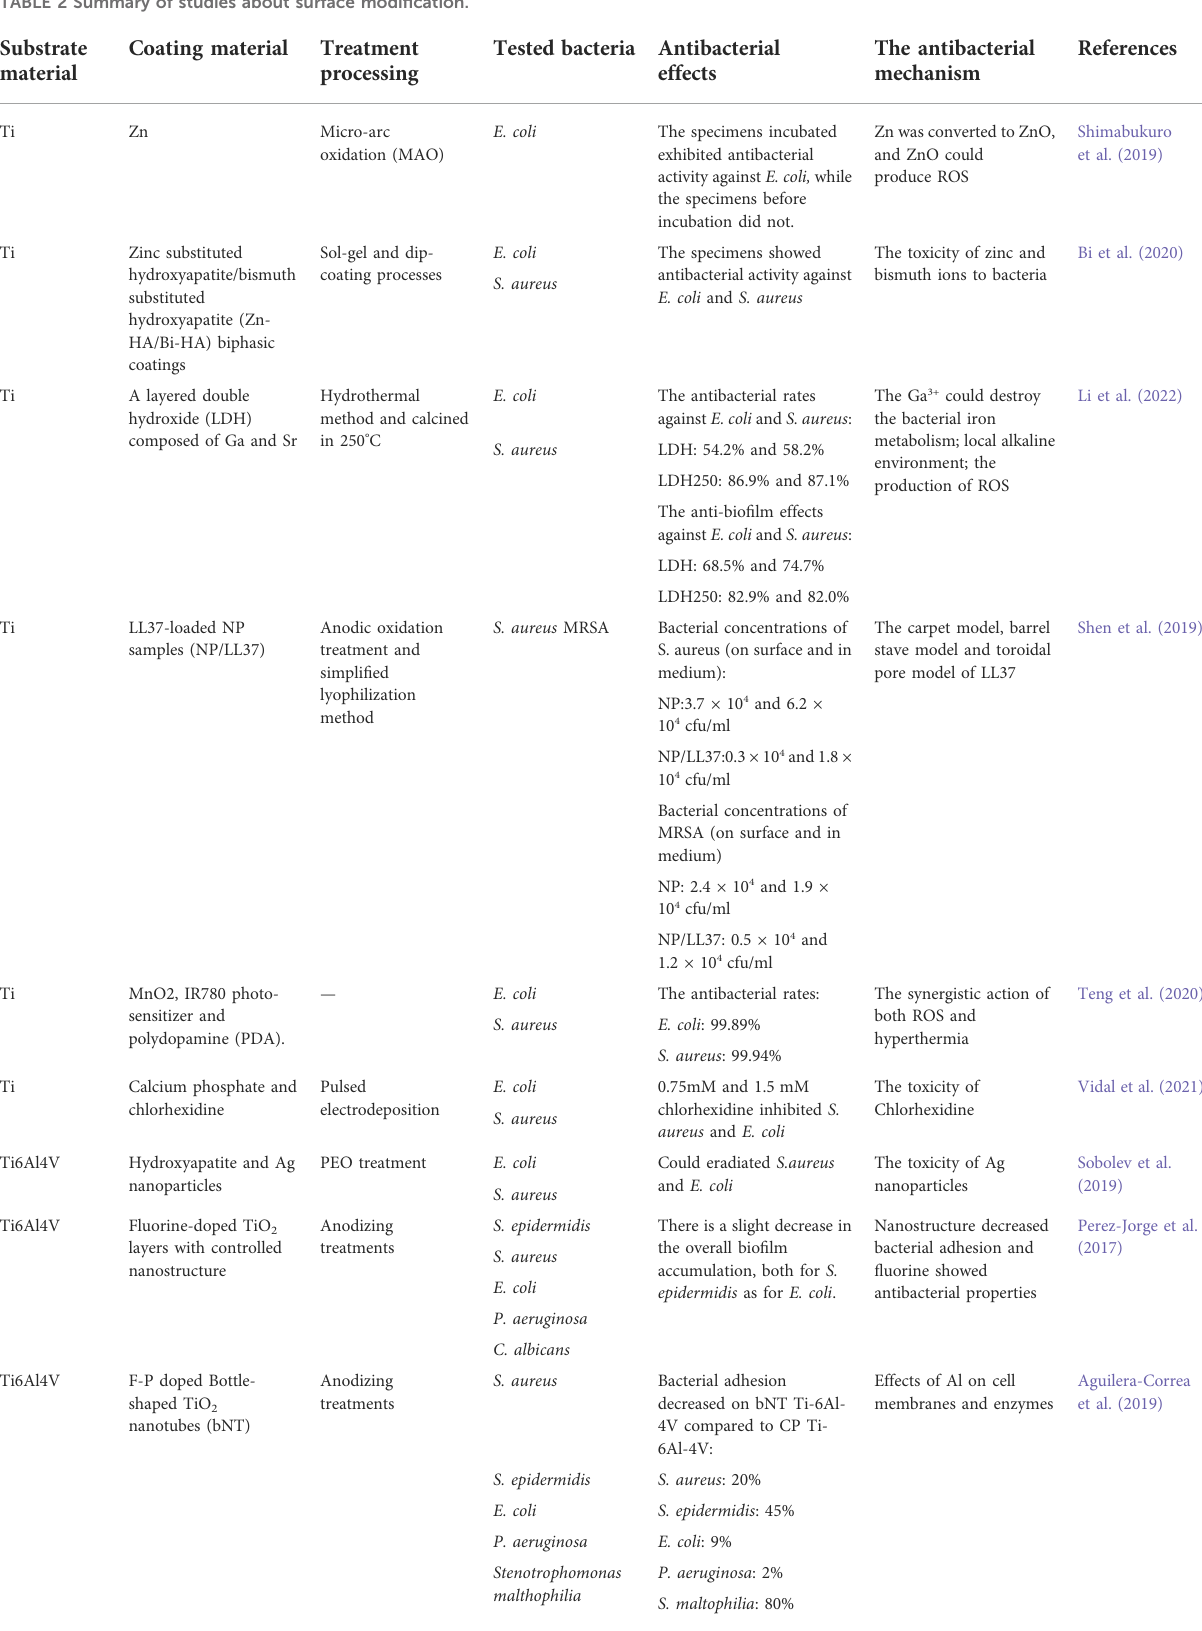
TABLE 2 Summary of studies about surface modi fi cation. Substrate